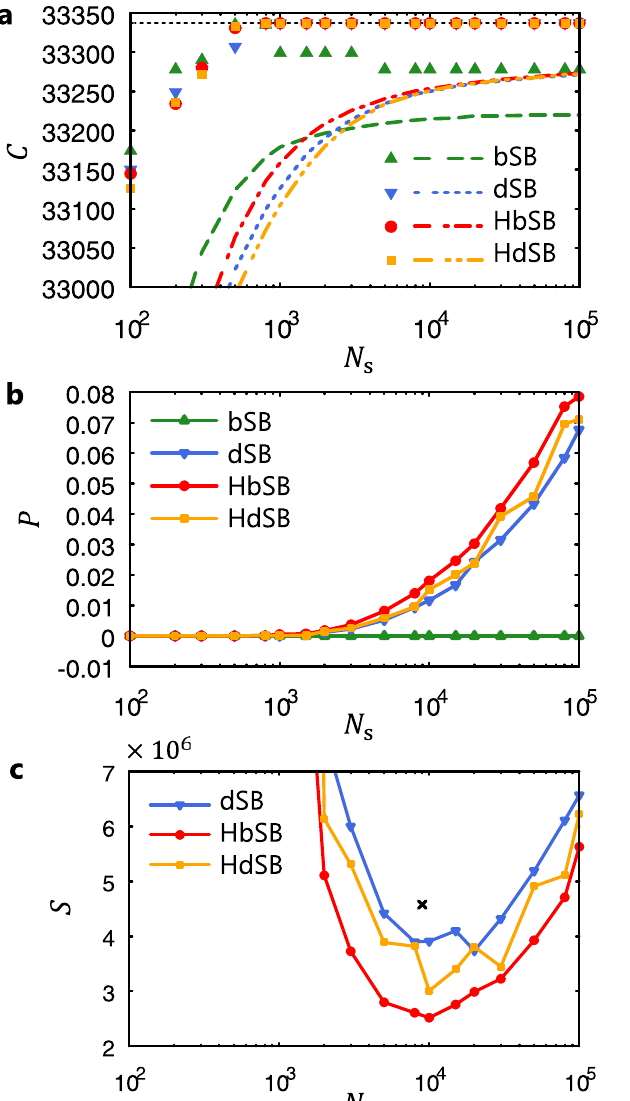
Fig. 3 Comparison of performance for K 2000 . a Average (lines) and maximum (symbols) cut values C as functions of the number of time steps, N s . The horizontal dashed line indicates the best known cut value C = 33337. The maximum C for dSB, HbSB, and HdSB coincide with C best for N s ≥ 800. b Probabilities for obtaining C best , P . c Step-to-solution S . The black cross is step-to-solution obtained from previously reported data for dSB 49 . Parameters Δ t , c 1 , and γ here are the same as in Fig. 1. SB means simulated bifurcation, and b, d, and H denote ballistic, discrete, and heated,